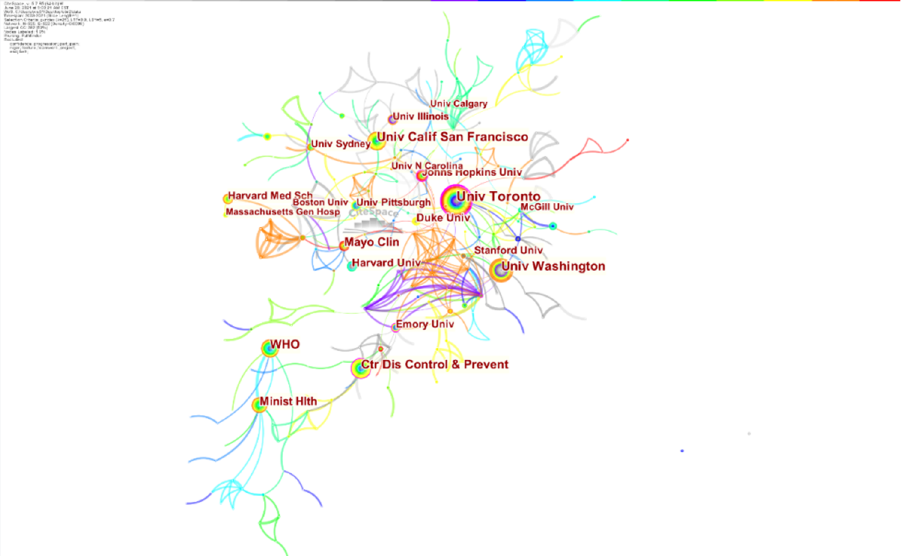
Figure 3. Institutional cooperation network related to CBR research.